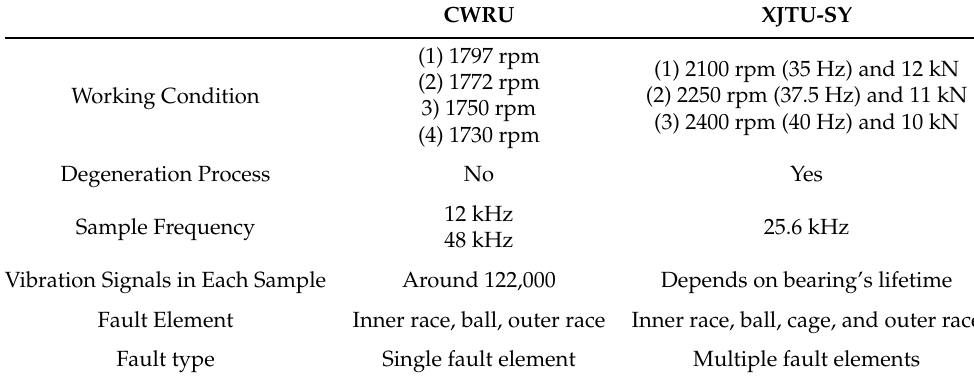
Table 1. Comparison of CWRU and XJTU-SY